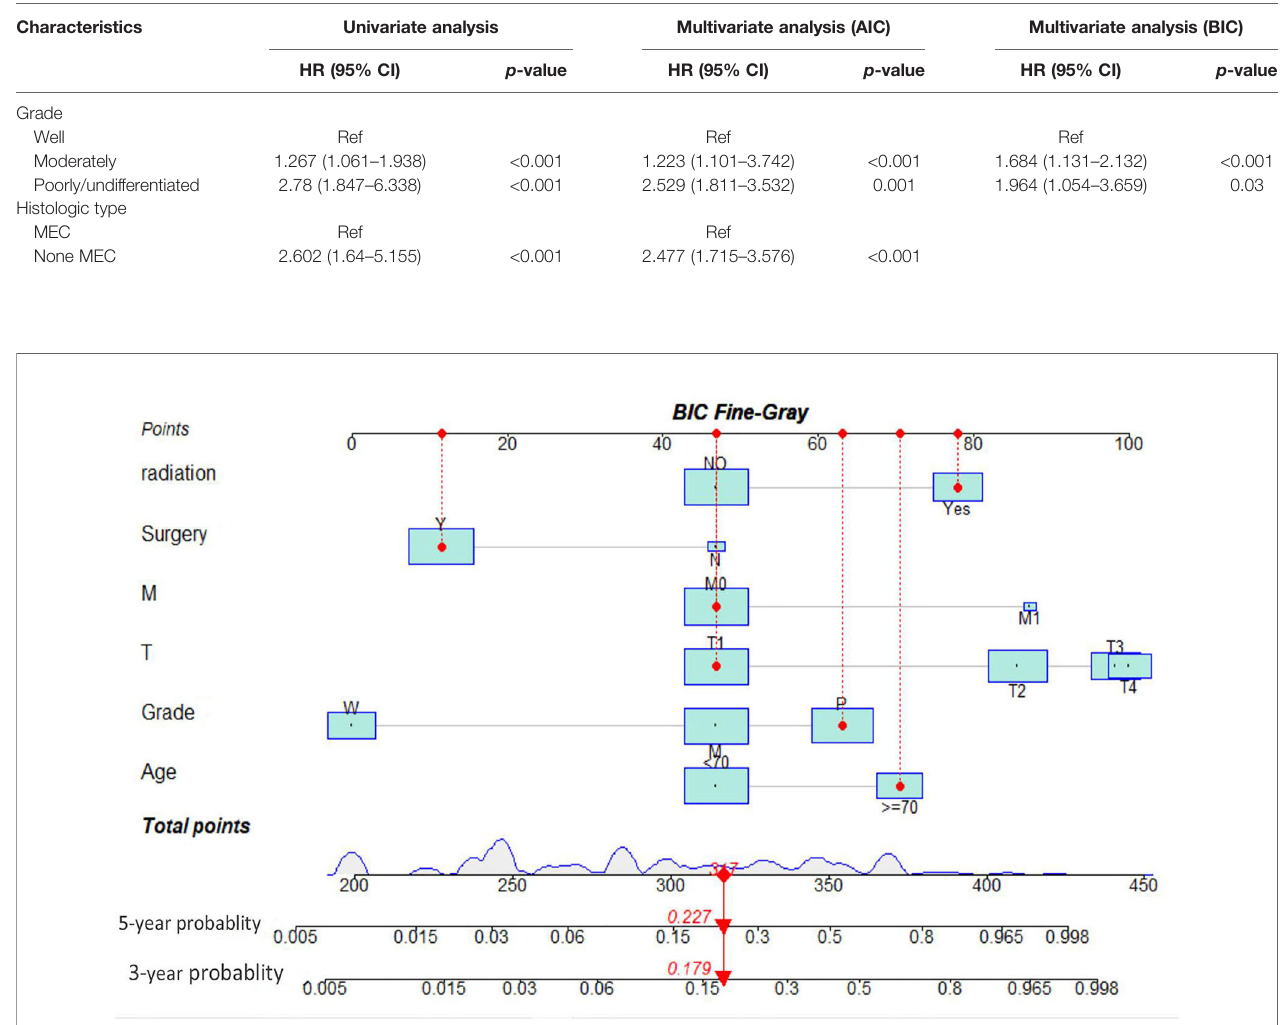
FIGURE 4 | Interactive nomogram for predicting 3- and 5-year likelihoods of CSD in parotid carcinoma. BIC, Bayesian information criterion; MEC, mucoepidermoid